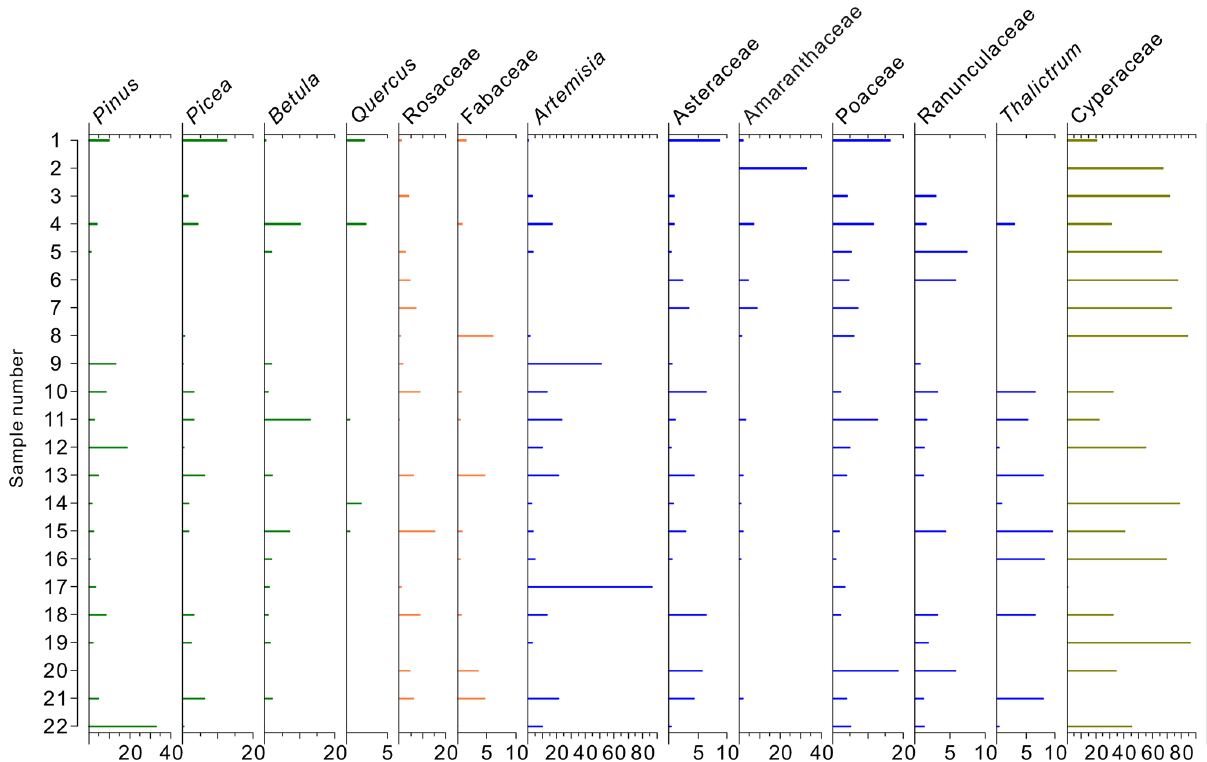
Figure A4. Pollen diagram of the modern pollen samples ( n = 22) in the vicinity of the Gahai